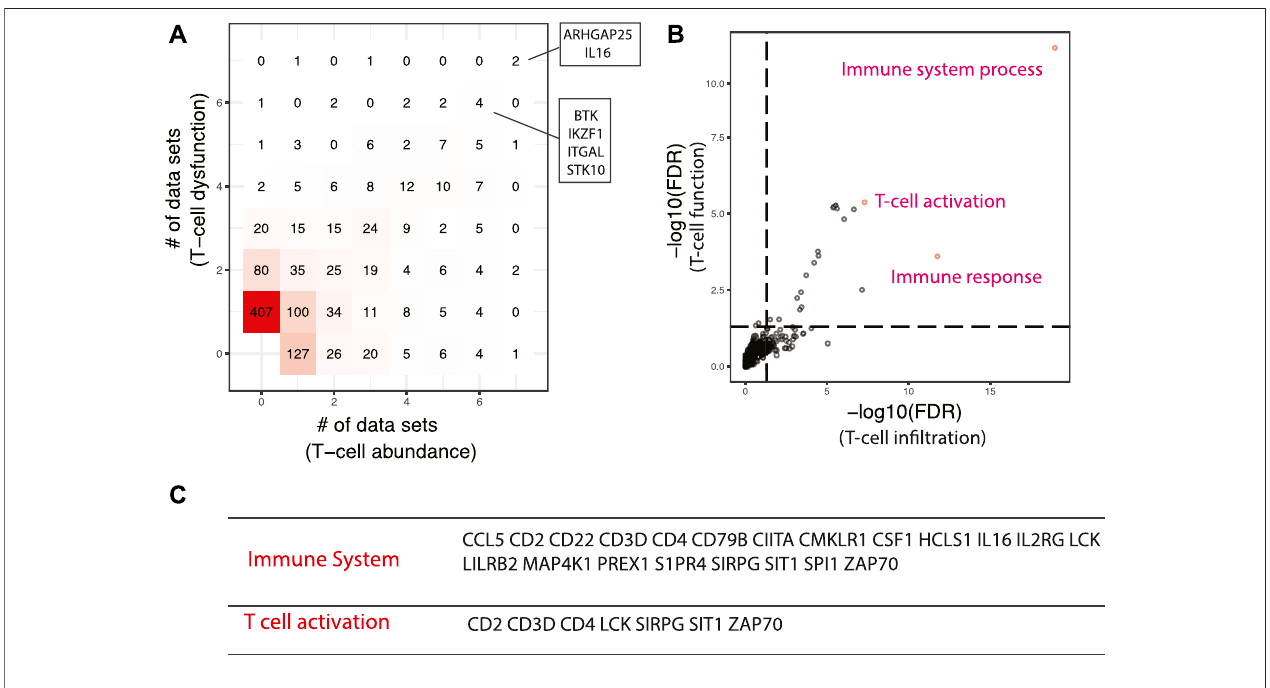
FIGURE 5 | Master regulators that are associated with enhanced responses in immune checkpoint blockade-based immunotherapy. (A) Comparison of master regulatorspredictedfromTcellin fi ltrationandTcelldysfunctionsignatures.Thesamesetofmasterregulatorsthatwereidenti fi edinatleastsixdatasetswereshown. (B) Pathways enriched in top-ranking master regulators. The top three most enriched pathways were shown. (C) Selected master regulators grouped by enriched